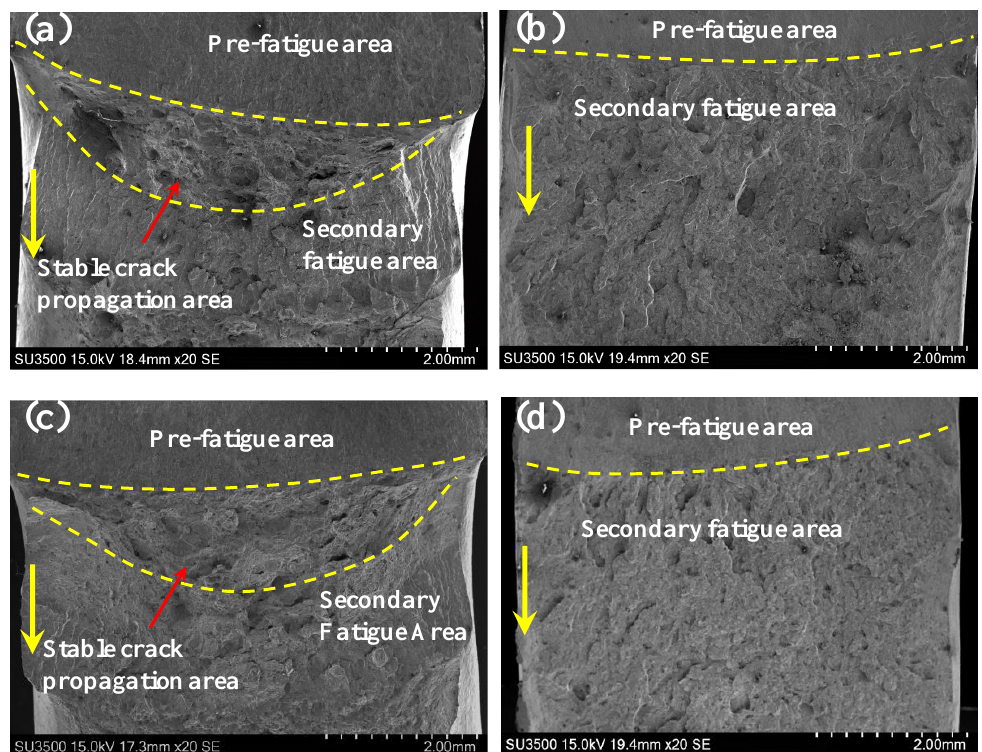
Figure 6. The macroscopic fracture surface. HF condition: ( a ) BM and ( b ) WM. HC condition: ( c ) BM and ( d ) WM. The yellow dash lines differentiate the different areas on fracture surface, and the yellow arrows mark the direction of crack propagation.